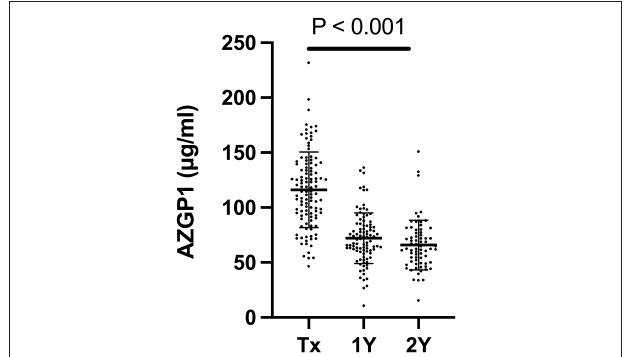
FIGURE 1 | Serum AZGP1 levels of kidney transplant recipients at the time of transplantation (Tx), 1 year (1Y) and 2 years (2Y) after transplantation. n Tx = 113, n 1Y = 97, n 2Y = 69. Graph shows individual values with means and corresponding standard deviations. Groups were compared by mixed-effects